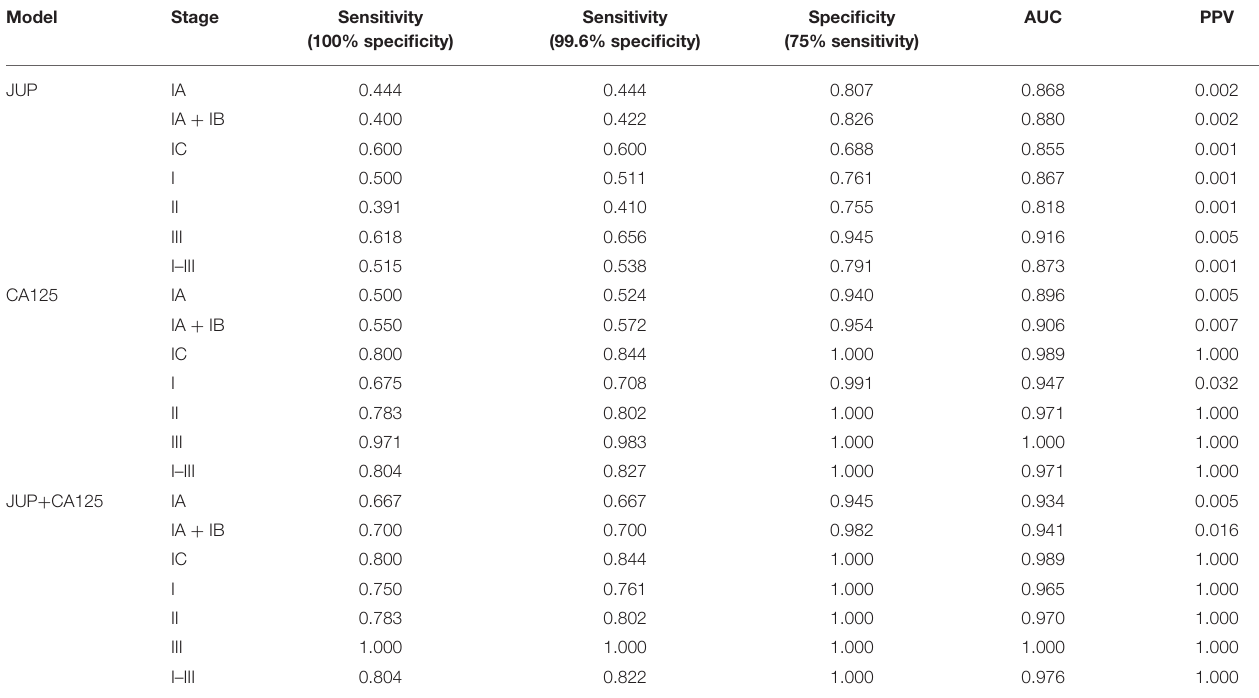
TABLE 2 | Sensitivities at a fixed specificity of 100 and 99.6%, specificities at fixed sensitivity of 75% and area under the curve (AUC) of JUP, CA125 and the combination of both markers for stage I–III serous ovarian cancer. Model